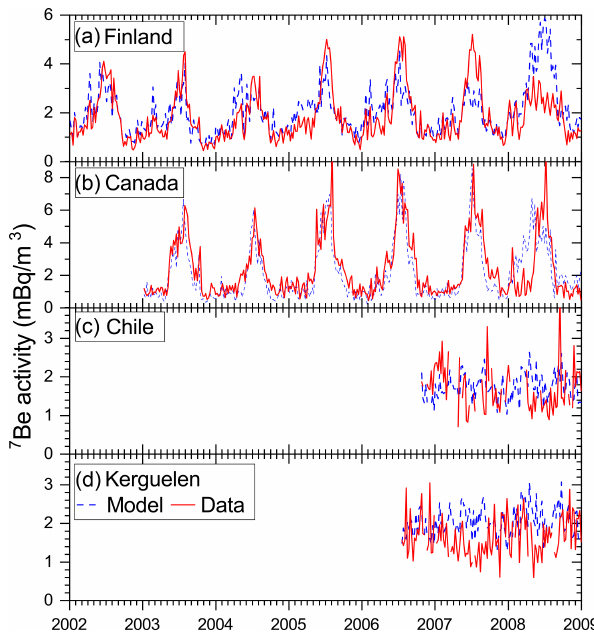
Figure 1. Datasets of 7 Be activity in the near-ground air used in this study, including (panels a through d , respectively) Finland (a composite of four stations), Yellowknife (Canada), Punta Arenas (Chile), and Kerguelen island (France) – see detailed information in Table 1. The measured and modeled activities are shown as solid red and dashed blue curves,